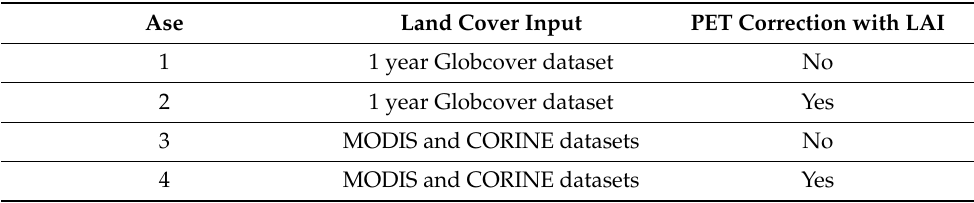
Table 2. Description of the model